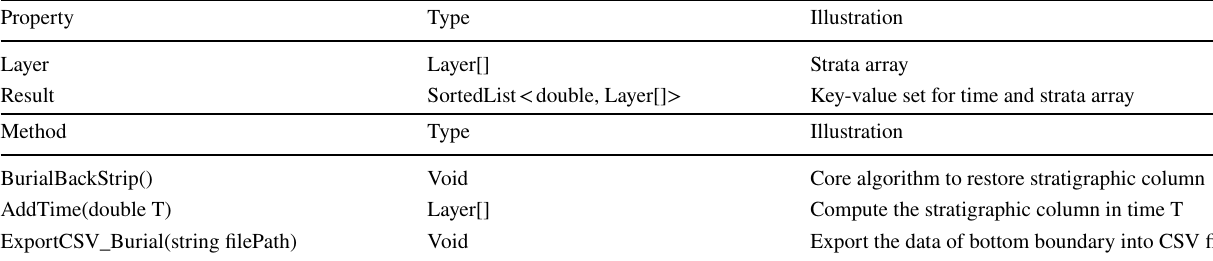
Table 8 BurialHis class